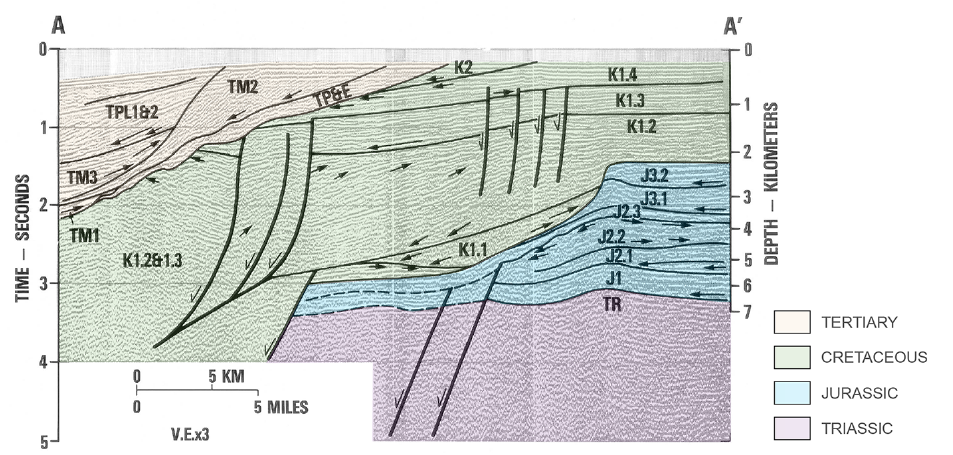
Figure 24. Seismic section from offshore north-western Africa showing sequences defined by seismic reflectors. Black lines show the sequence boundaries (modified from Mitchum and Vial, 1977).